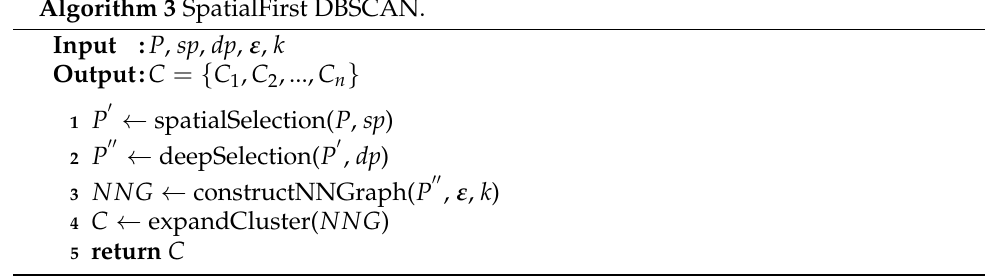
Algorithm 3 SpatialFirst